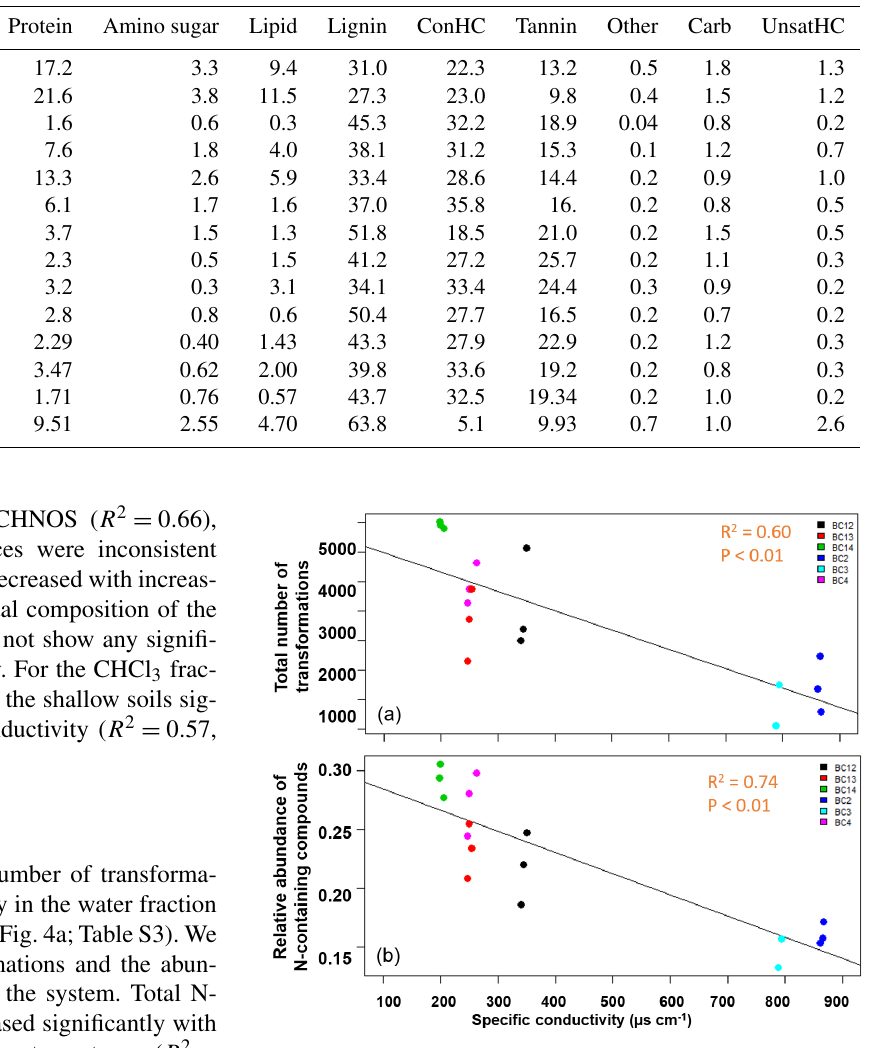
Figure 4. The total number of inferred transformations (a) and total abundance of N-containing compounds (b) in the water fraction of shallow soils impacted by tidal inundation show significant negative correlations with increasing specific conductivity. No significant re- lationships were observed for water fraction of deeper soils or for the CHCl 3 fraction in shallow or deeper soils. The salinity of the soil samples did not follow a clear spatial